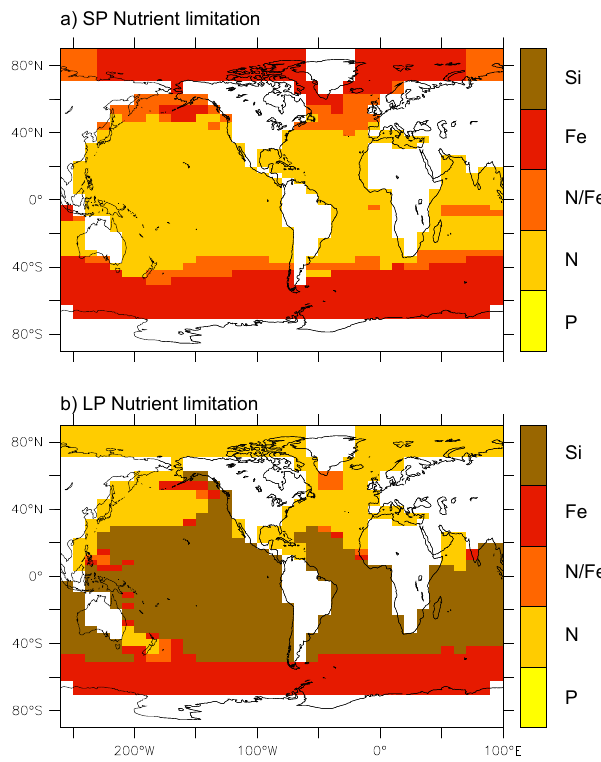
Fig. 9. Simulated annual mean nutrient limitations for the small phytoplankton (a) and large phytoplankton (b) from MESMO